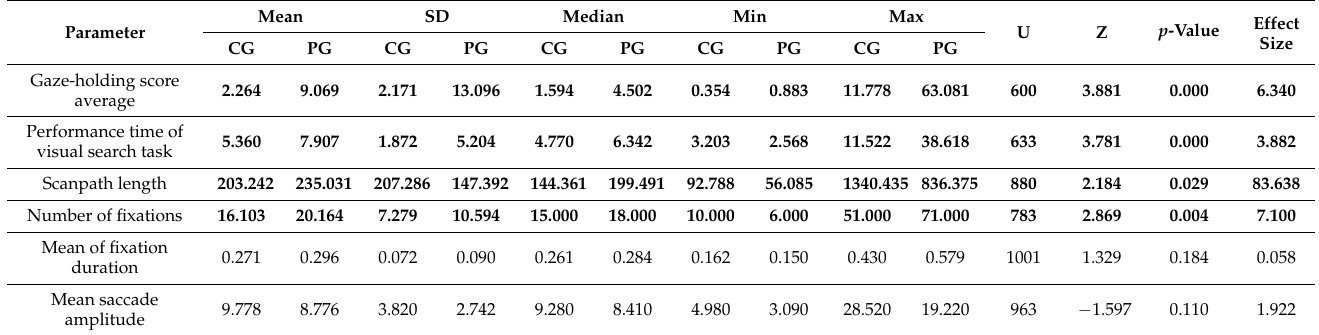
Table 2. The gaze-holding score and parameters of visual search task in the control group (CG) and in the group of children who survived cerebellar tumor (PG). Values in bold indicate statistically significant